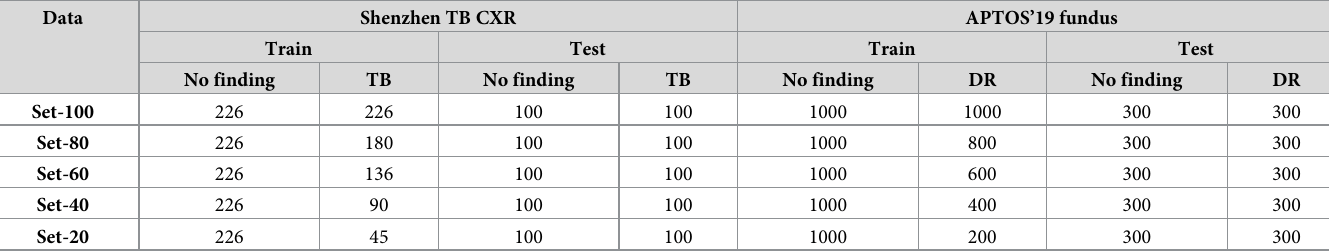
Table 1. Class imbalance-simulated sets constructed from the datasets used in this